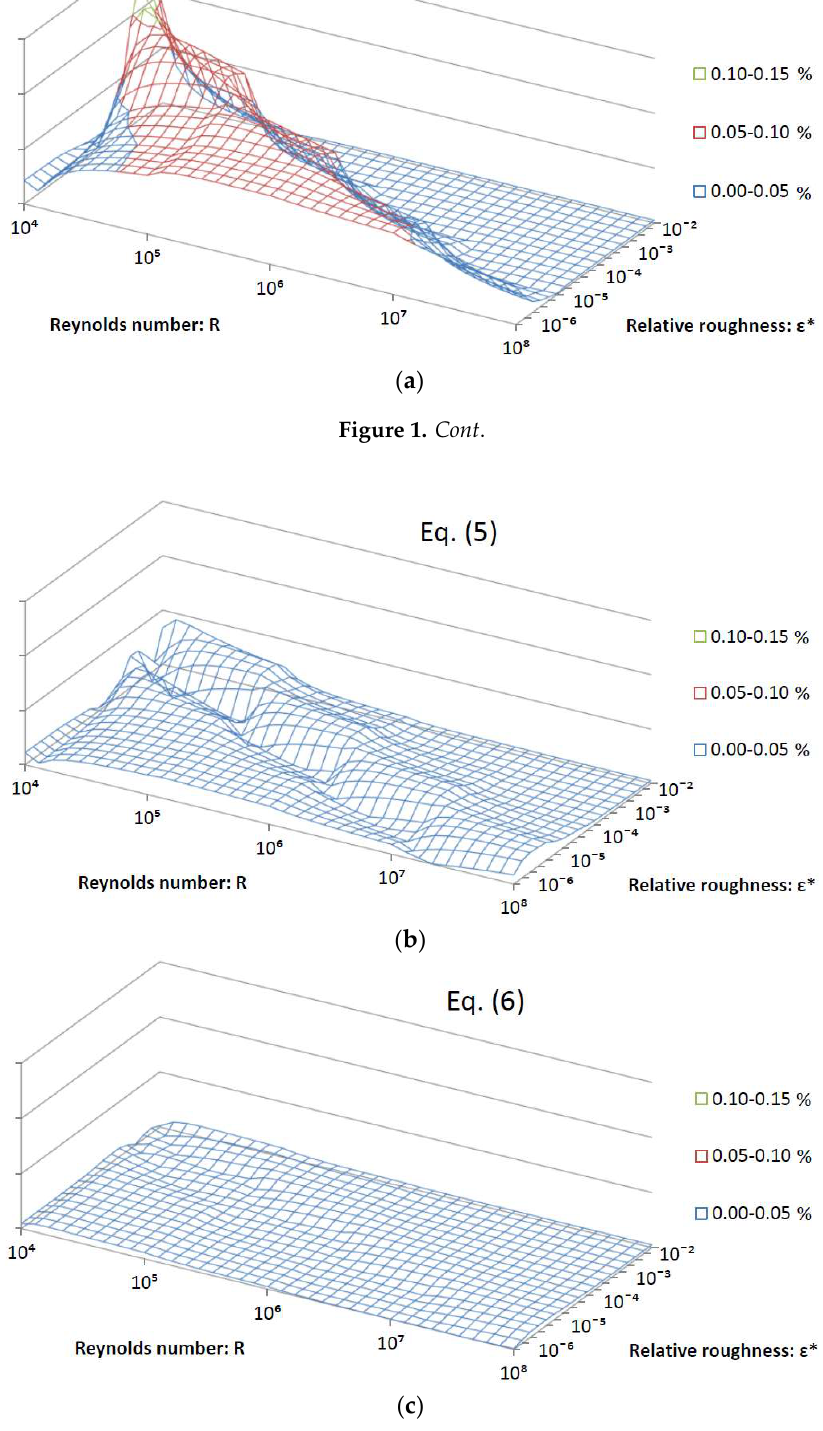
Figure 1. Distribution of the relative error by the proposed explicit approximation of Colebrook’s equation; ( a ) Equation (3), ( b ) Equation (5) and ( c ) Equation (6); comparison.